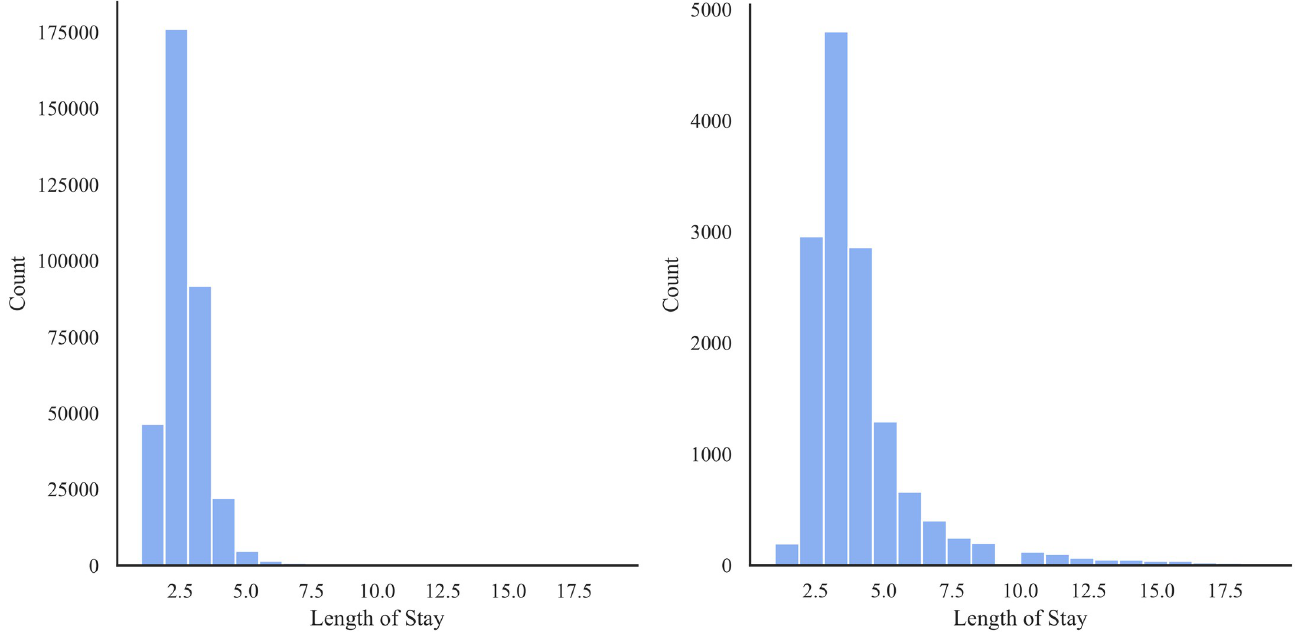
Fig 4. Distribution of length of stay for the Texas PUDF—Left: Women without PE; Right: Women with PE.